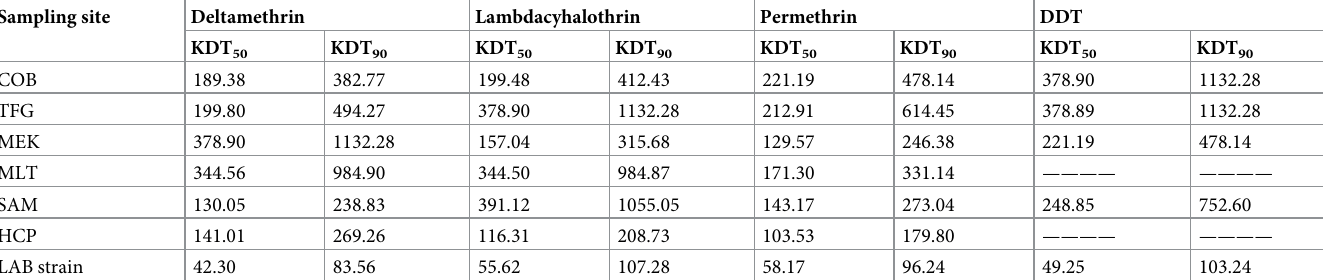
Table 3. KDT 50 and KDT 90 values (in minute) of Cx . quinquefasciatus populations against Synthetic pyrethroids and DDT. Sampling